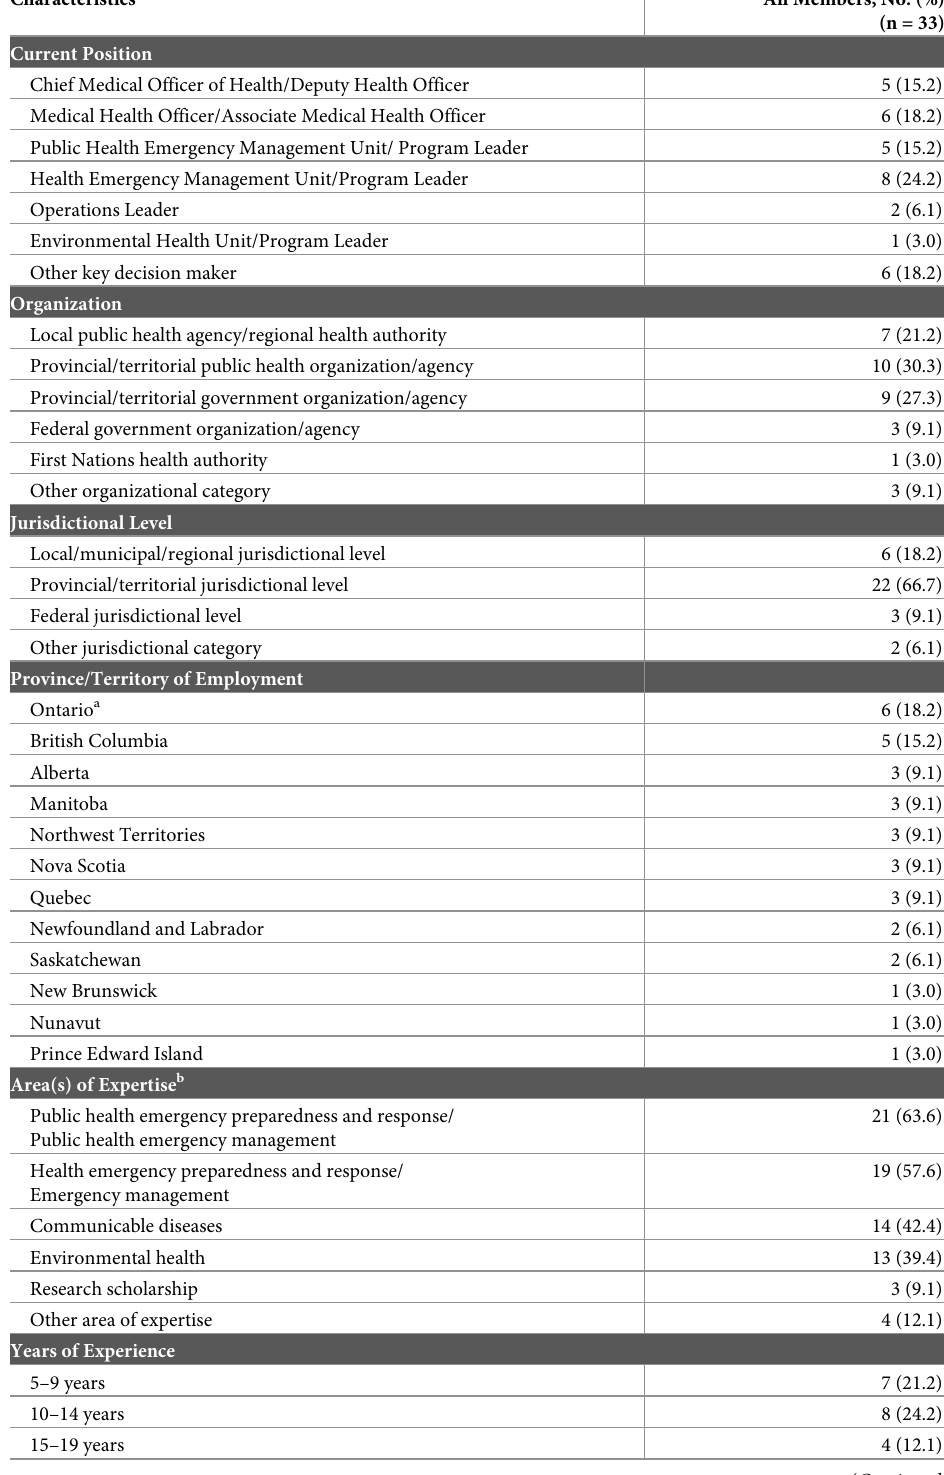
Table 1. Characteristics of public health emergency preparedness expert panel